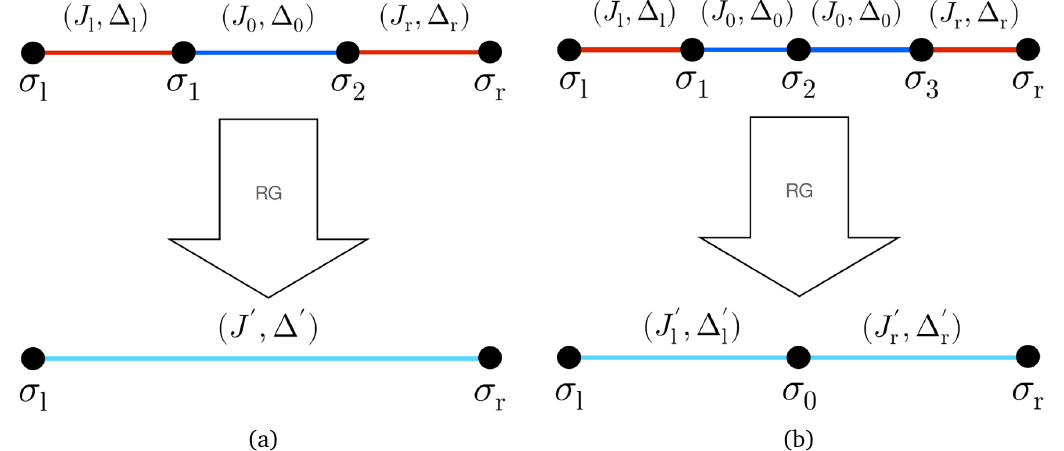
Figure 5: Strong disorder renormalization step involving a block of 2 (a) and 3 (b) spins connected by strong bonds. Strong bonds are depicted in blue, while all other weaker bonds are shown in red. Whether the bonds in the renormalized chain (de- picted in cyan) are strong or not can only be determined a posteriori, by compar- ing the renormalized couplings after the RG transformation has been applied to the whole